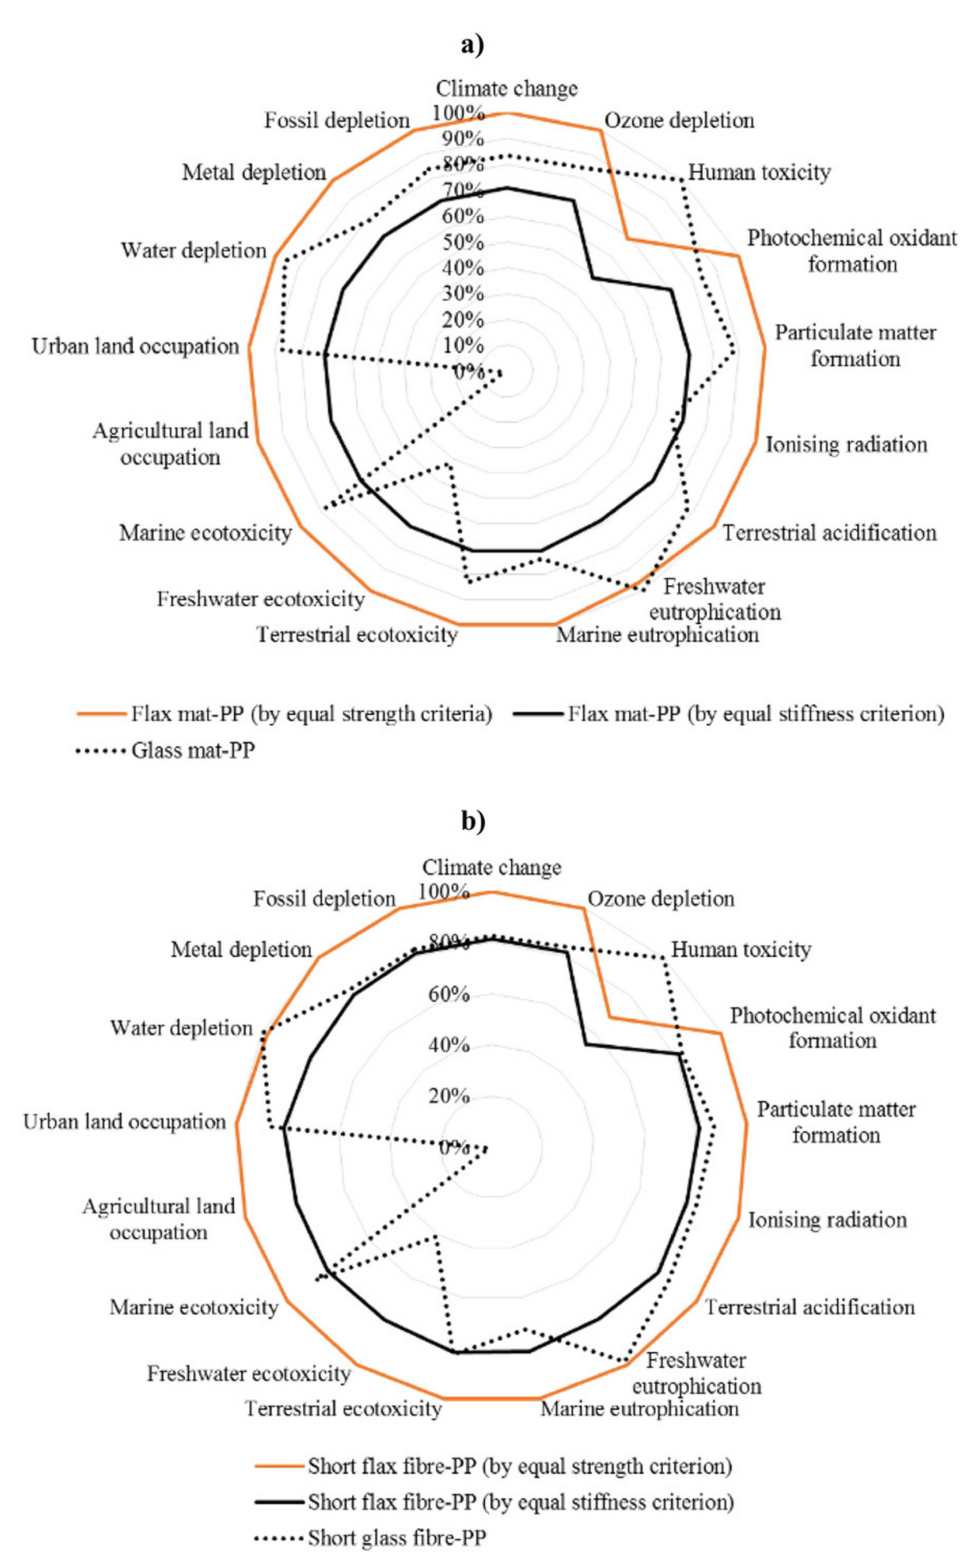
Figure 16. Life cycle impact comparison between flax fiber-reinforced polymers (FRPs) and glass fiber-reinforced polymers (GFRPs) with equal sti ff ness and equal strength design criteria. ( a ) Flax mat-PP. ( b ) Short flax fiber-PP. Reprinted from [71], © 2020 with permission from